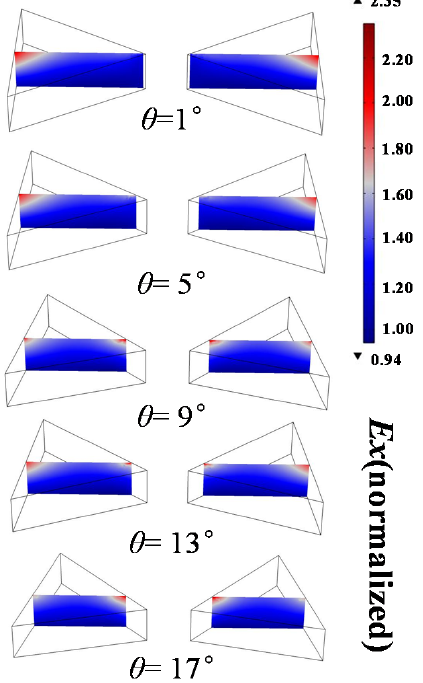
Figure 6. Electric field distribution of 175 nm side length Au bowties placed at rotations of 1 ◦ , 5 ◦ , 9 ◦ , 13 ◦ , and 17 ◦ under 565 nm incident wavelength. The cross-sections show the X component of the local field, normalized by the incident field amplitude, plotted at one instance in phase. Field distribution for a cross-section through the center of the YZ plane. The field appears to penetrate further into the reflect air layer in the case of a 9 ◦ rotation.